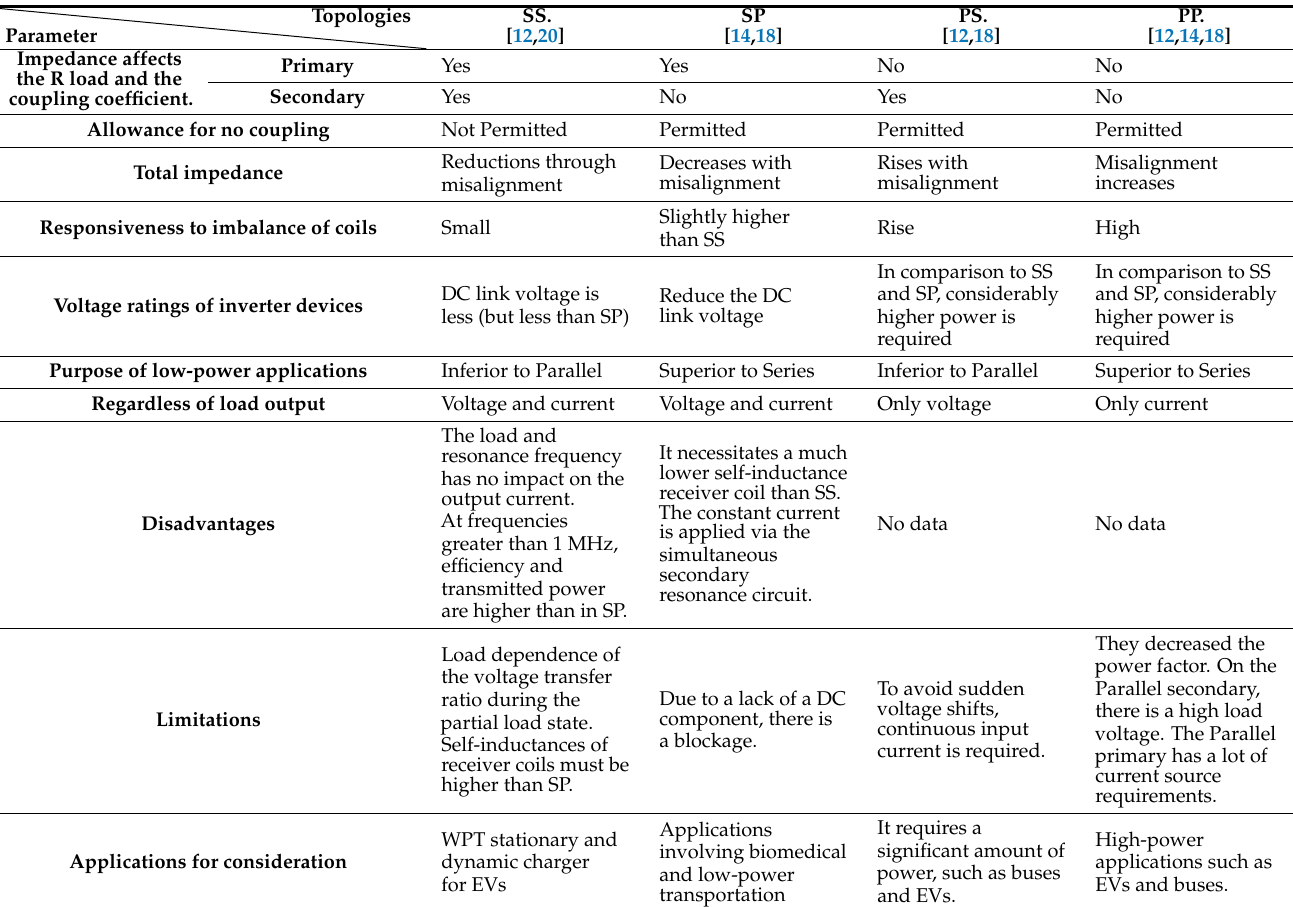
Table 2. Comparative analysis of four fundamental topologies for recommended